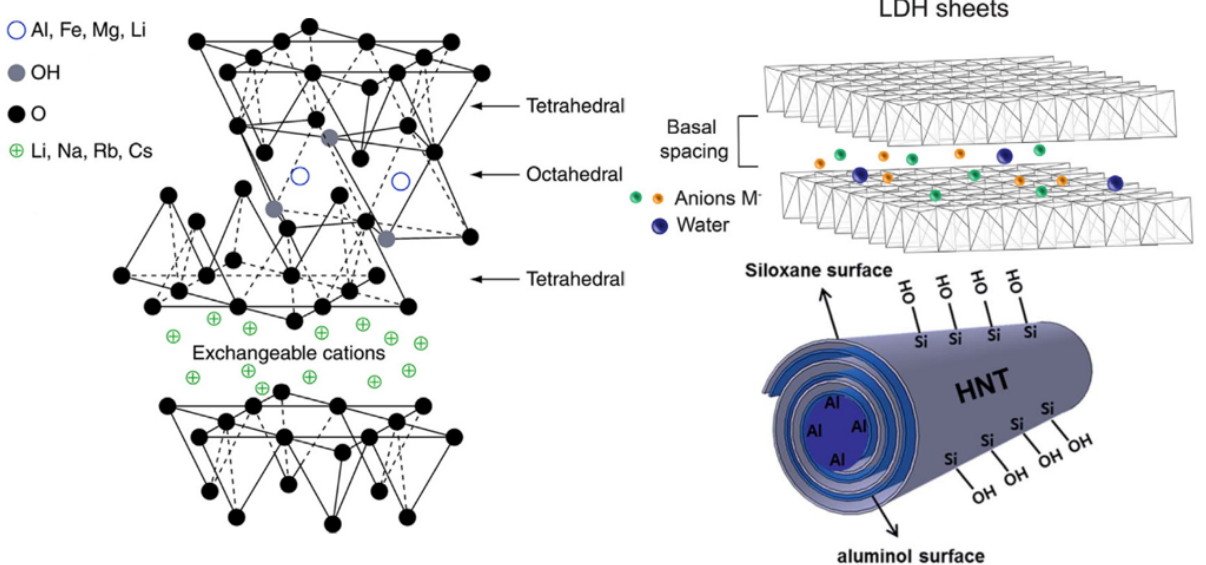
Figure 3. Structure of the most-used clay minerals. Cationic 2:1 layered silicates (such as Smectites). (Reprinted with permission from [25]. Copyright 2017, Elsevier). Anionic layered double hydroxides (LDH). (Reprinted with permission from [26]. Copyright 2021, Elsevier). Basic 1:1 kaolinite silicate rolled over to form halloysite nanotubes (HNTs). (Reprinted with permission from [27]. Copyright 2017, Royal Society of